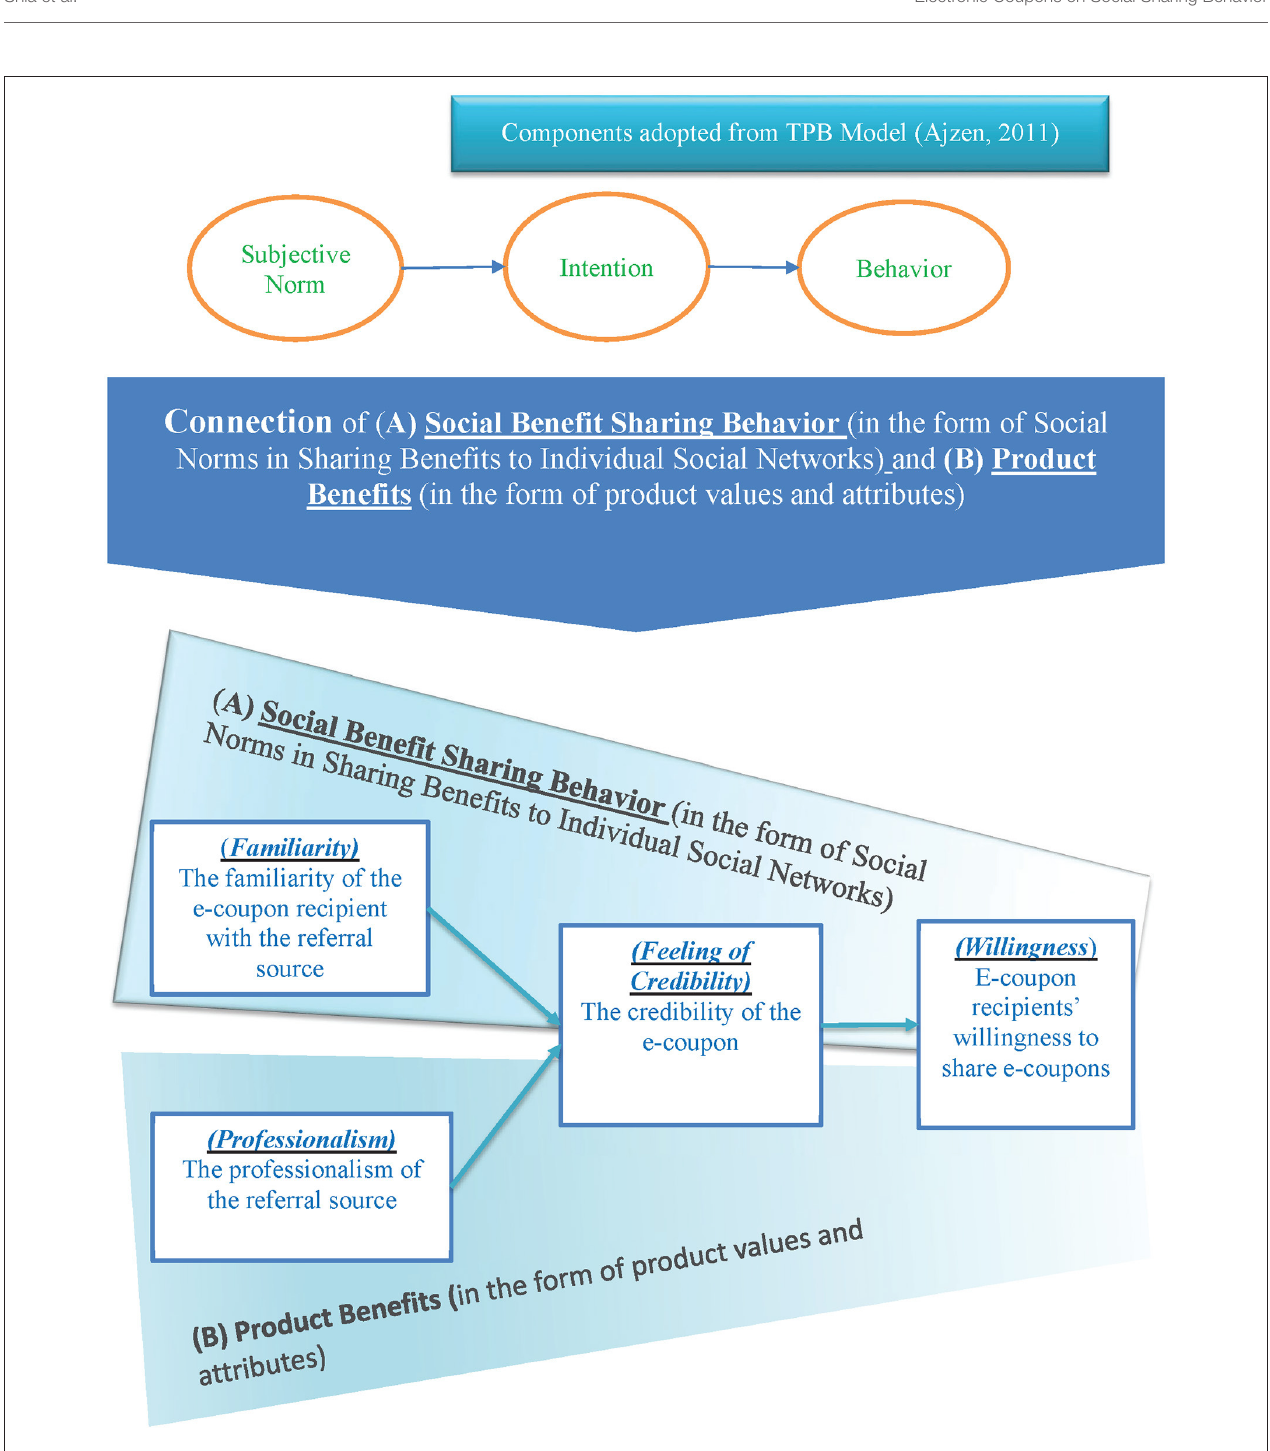
FIGURE 3 | Connection mechanism between social benefit sharing behavior and product benefits (Source: this study).